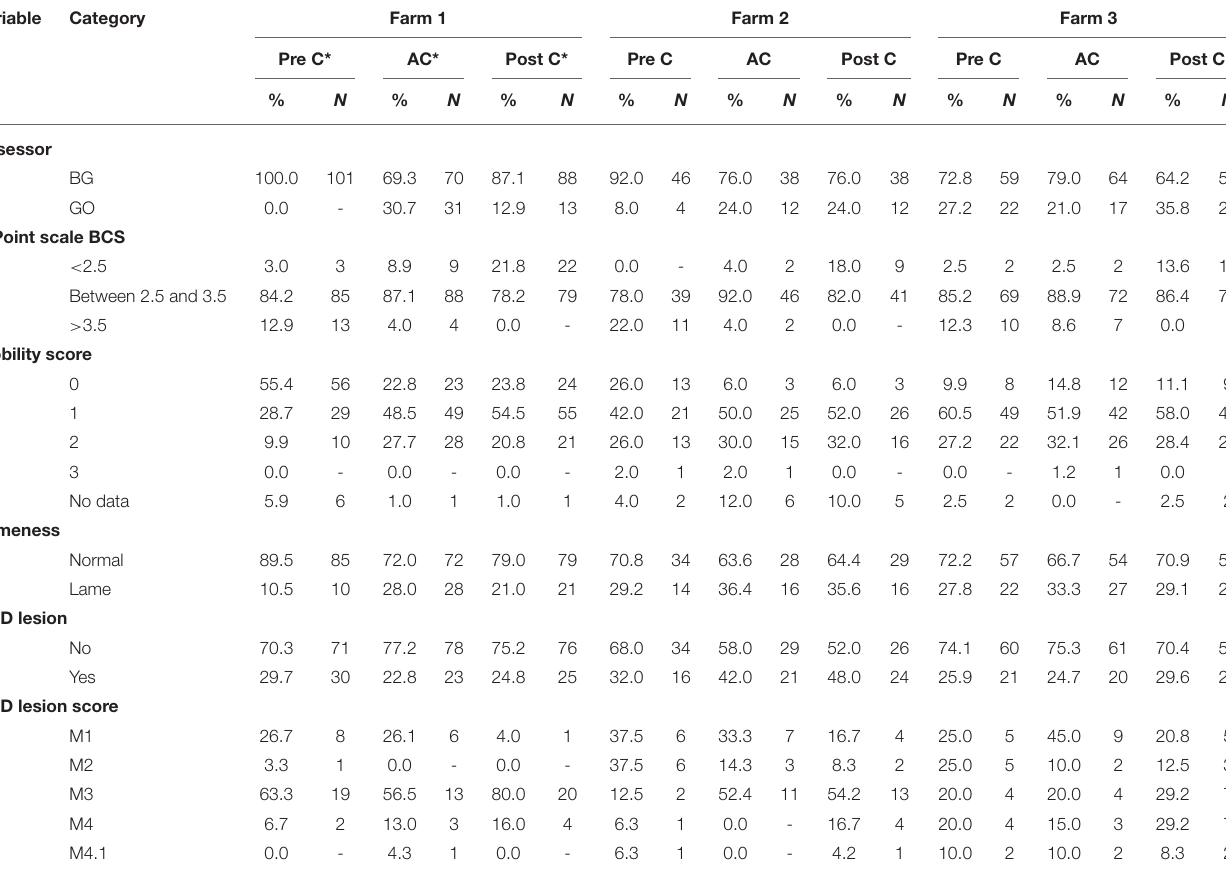
TABLE 3 | Summary statistics of categorical variables per data collection time point across farms. Variable